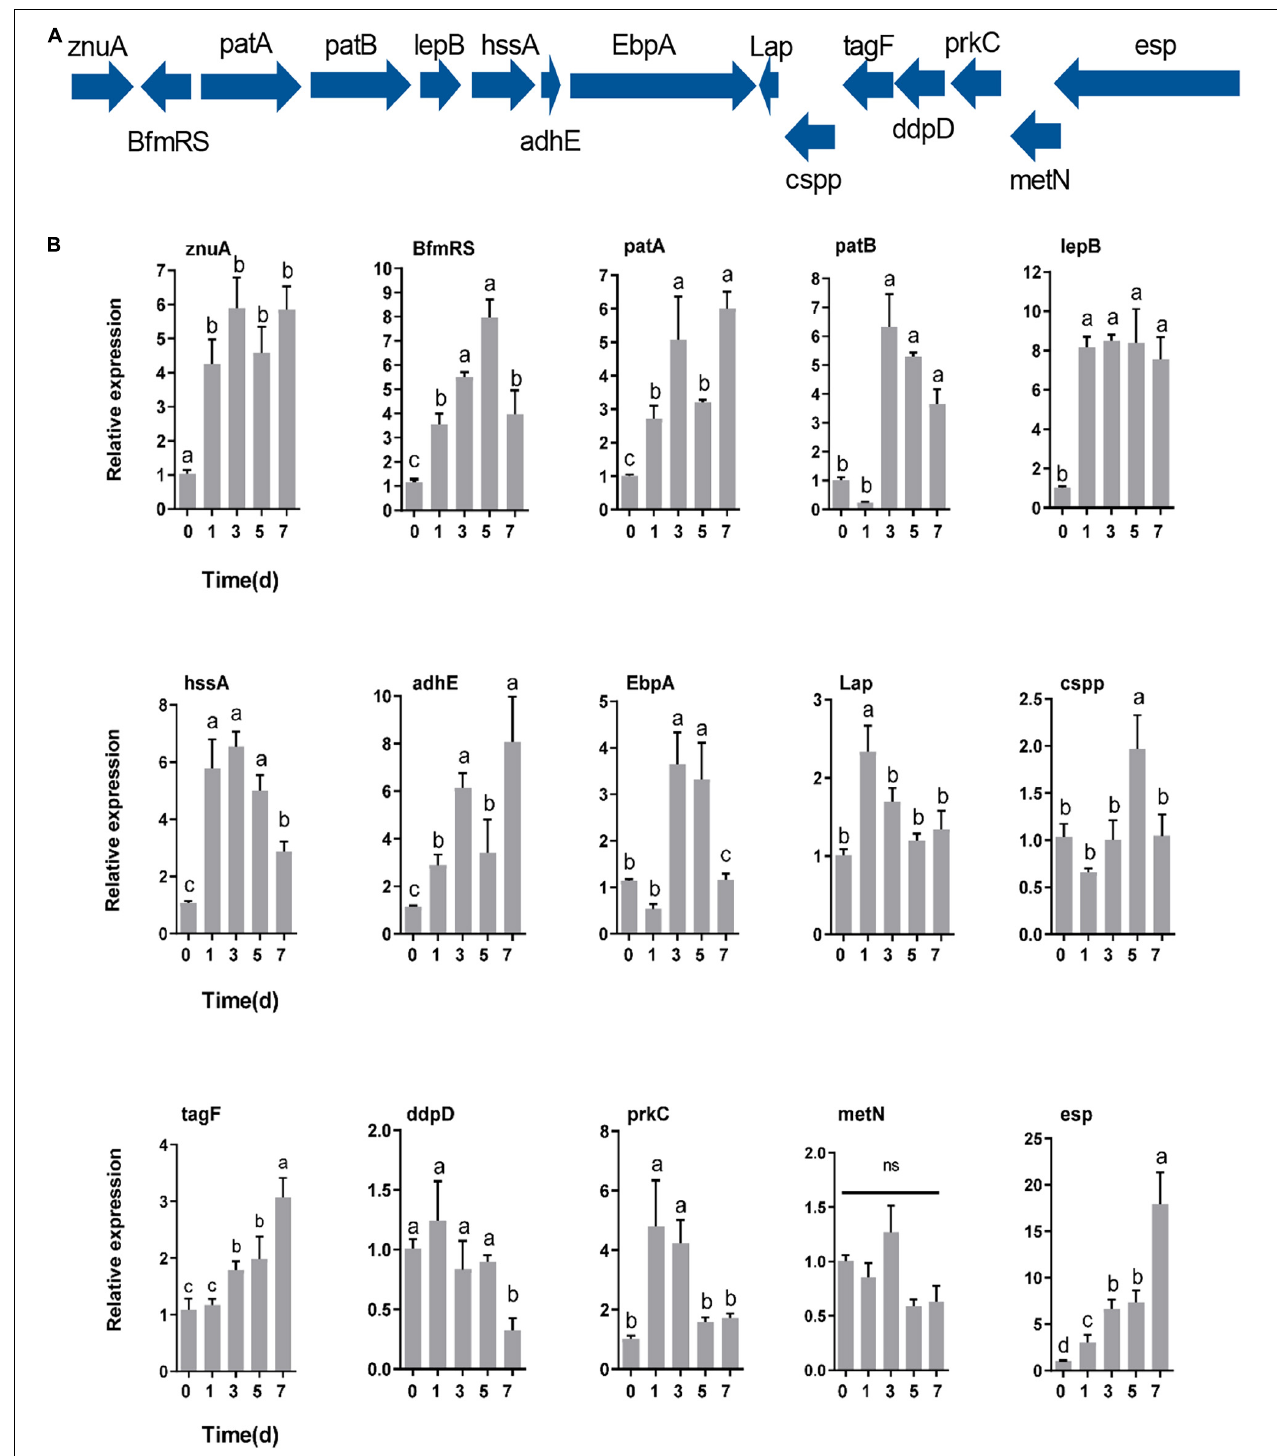
FIGURE 7 | Genes specifically contributing to gut colonization. (A) Colonization-related gene expression at different times (0, 1, 3, 5, and 7 days) after inoculation with E. faecalis LX10 (10 7 CFU/mL) by RT–qPCR. (B) The mean ± standard error of the mean (SEM) of experiments performed in quintuplicate, with 10 silkworms/experiment, are shown. Variation analysis was performed by one-way ANOVA followed by Tukey’s post-hoc test. Different letters represent significant differences at p < 0.05. Adhesin genes ( znuA , lepB , hssA , adhE , EbpA , and Lap ), defense genes ( cspp , esp , and tagF ), a regulatory gene ( BfmRS ), a secretion system gene ( prkC ), immune evasion genes ( patA and patB ), and iron acquisition genes ( ddpD and metN ).